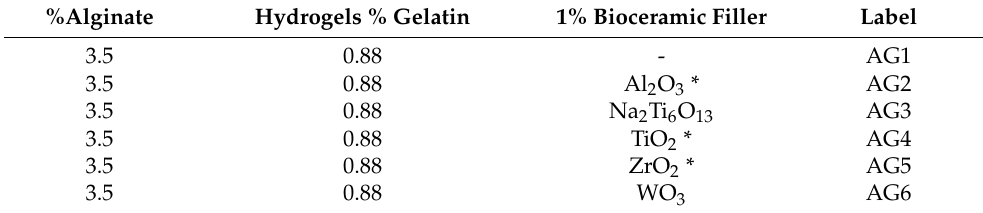
Table 1. Label samples by their